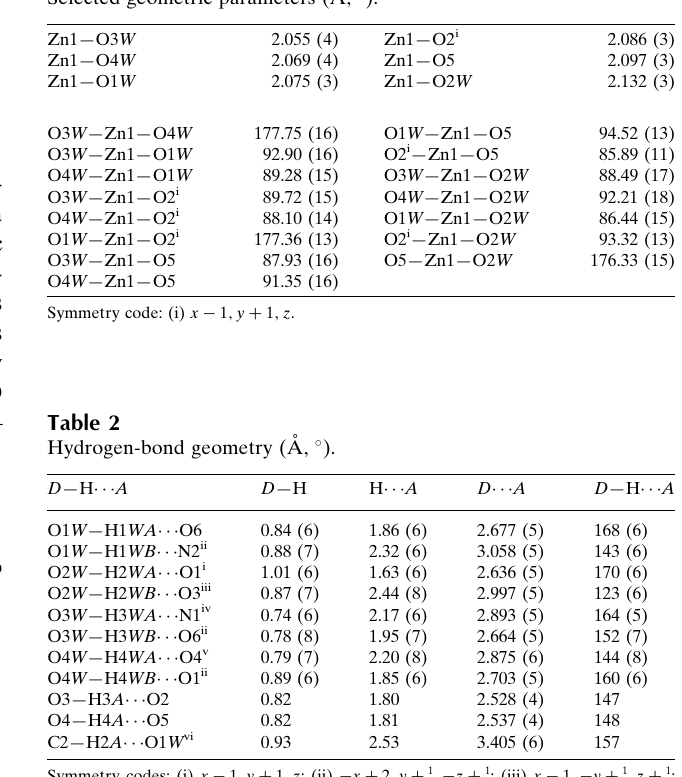
Selected geometric parameters (A˚ , (cid:2) ).